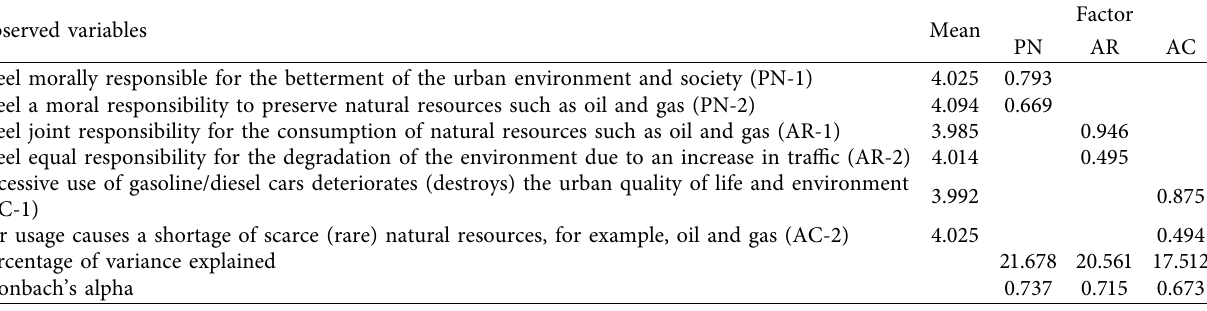
Table 3: Rotated factor loadings of the NAM